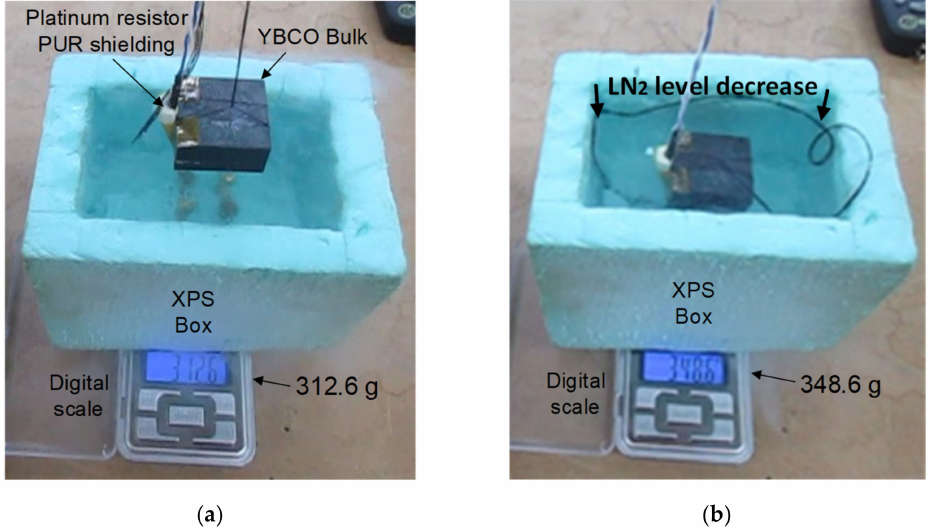
Figure 3. The XPS box with LN2 just before ( a ) and 60 s after ( b ) the bulk immersion. From Figure 3a, related to the instant before immersing the bulk into the LN 2 , one can see the four thin copper rods fixed at the box cavity bottom below the LN 2 level. As one may verify from Figure 3b, the heat released from the YBCO bulk in response to this stepped temperature transition caused LN 2 boiling and the consequent reduction of the LN 2 level. The amount of heat